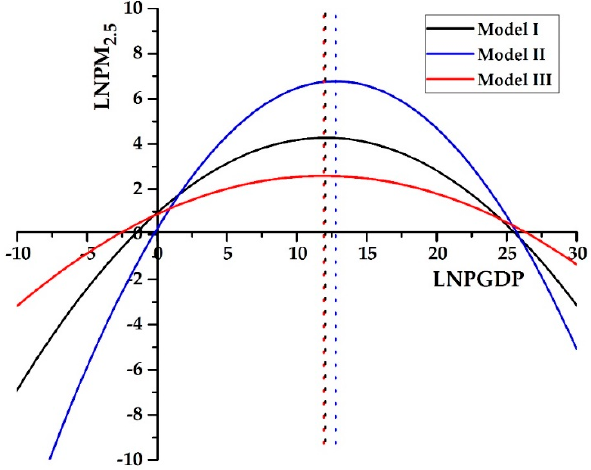
Figure 10. Environmental Kuznets curve (EKC) hypothesis between economic growth and PM 2.5 concentration in the ten prefecture-level cities of the YRB from 2000 to 2013. The dashed line refers to the turning point of per capita GDP, respectively, in Model I, Model II, and Model III.